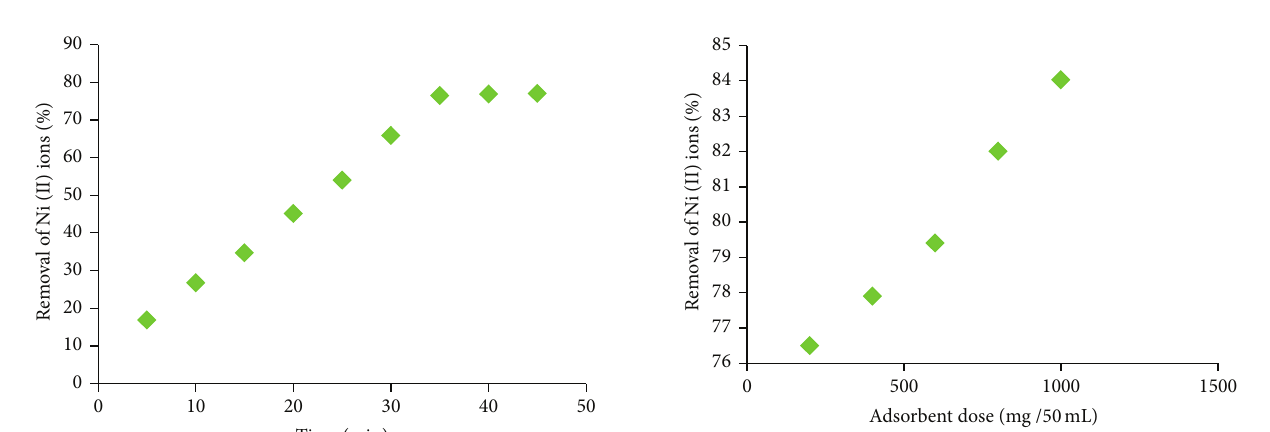
Figure 7: Effect of contact time on the adsorption of Ni (II) ions onto TGAN.